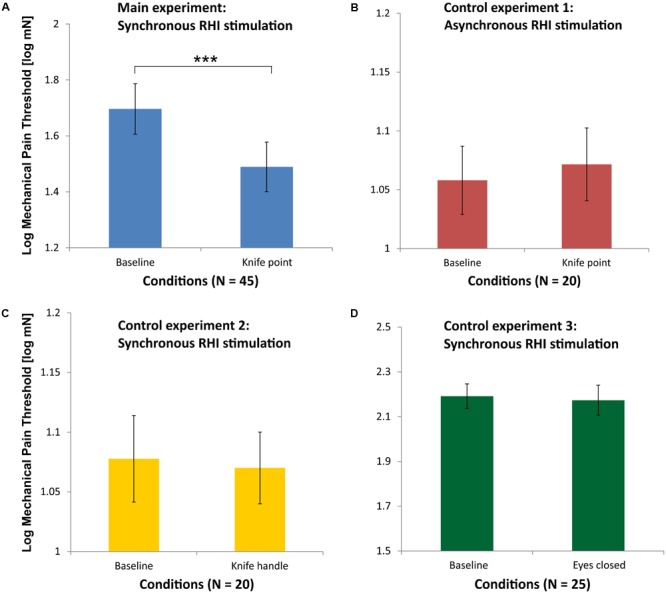
Mean Log mechanical pain thresholds (MPT) for the main experiment (blue, A), control experiment 1 (red, B), control experiment 2 (yellow, C), and control experiment 3 (green, D). Please note that the abscissae differ in scaling for sake of clarity. The data of all 45 participants entered the analysis in the main experiment, while control experiment 1 and 2 were completed by 20 subjects and conducted by examiner JH and control experiment 3 was completed by 25 subjects and conducted by examiner AB (∗∗∗p < 0.001; error bars depict SE).